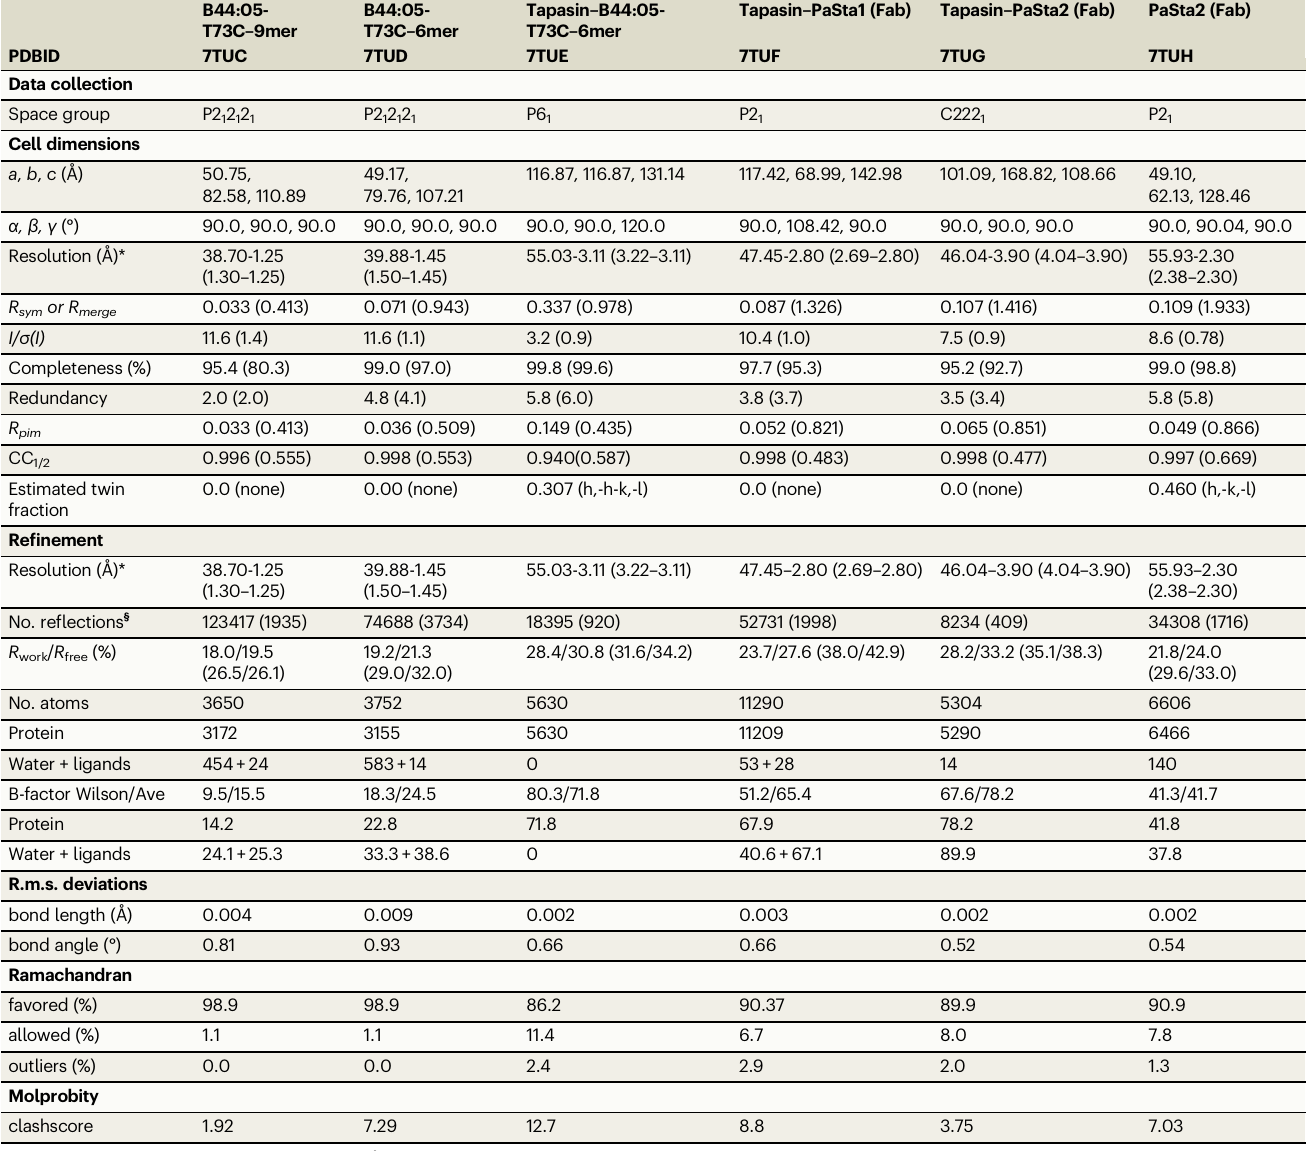
Table 1 | X-ray data collection and re fi nement